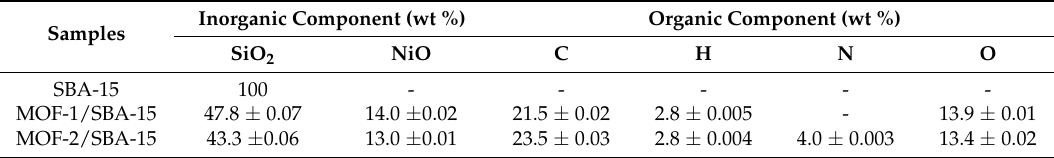
Table 1. The composition of the samples.